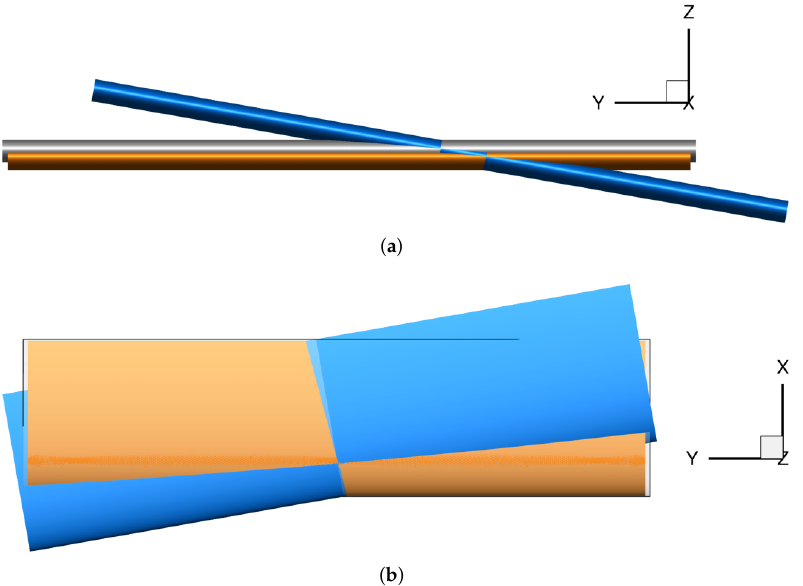
Figure 3. Linear rigid body displacements (blue) and quadratic displacement components (orange) against undisplaced geometry (gray). ( a ) Roll motion; ( b ) yaw